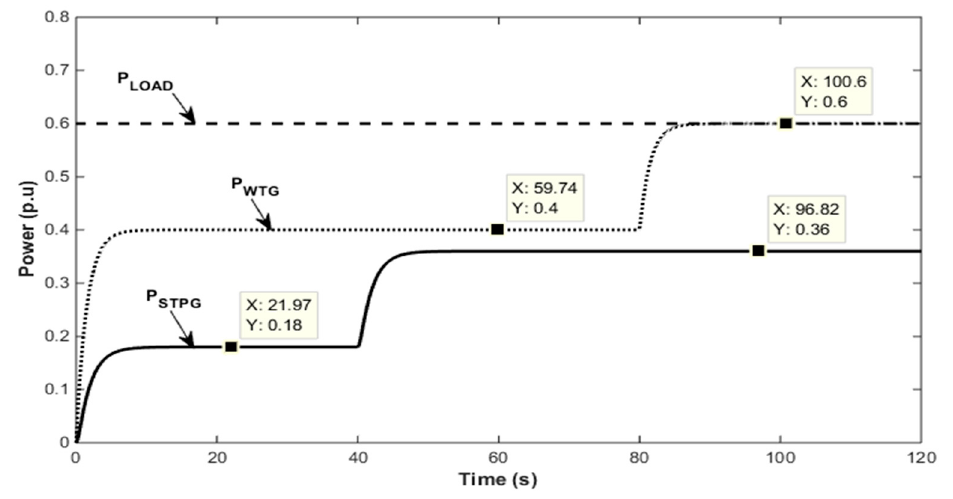
Figure 3. Power-sharing between a wind generator, solar thermal power system, and load in case 1.